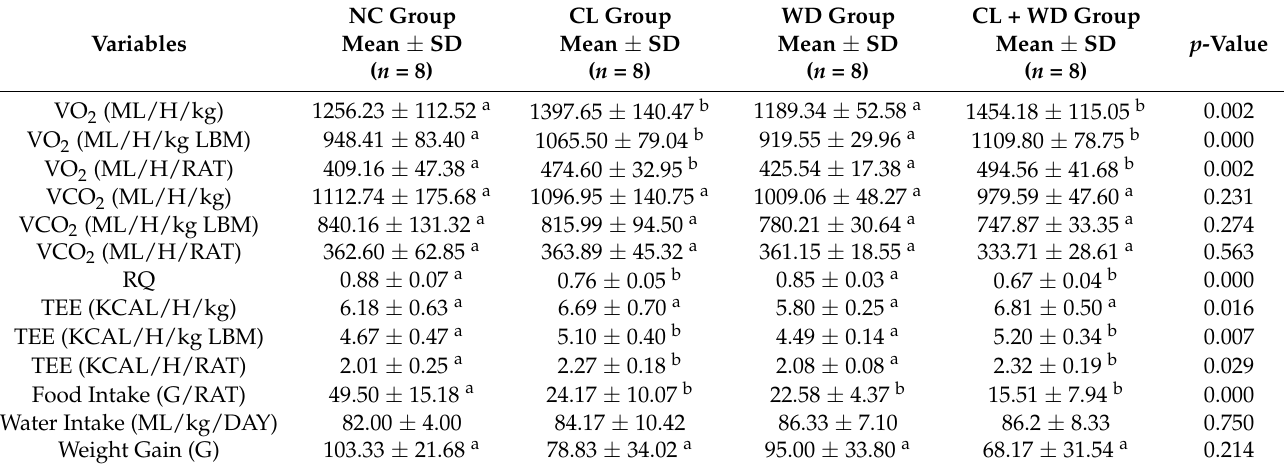
Values with the different superscripts within a raw are statistically significant according to the LCD post hoc test with Bonferroni correction ( p < 0.05). VO 2 = Volume of consumed oxygen, VCO 2 = volume of the produced carbon dioxide, LBM = lean body mass, RQ = respiratory quotient (VCO2/VO2), and TEE = total energy